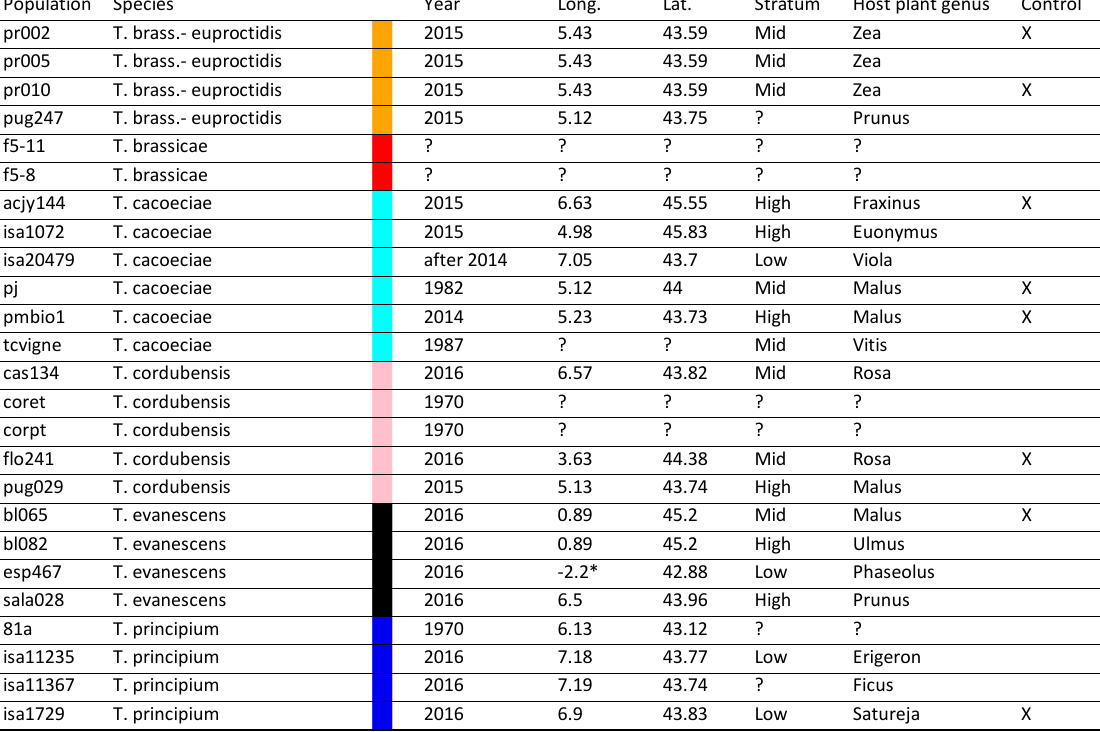
Table 1. List of the 25 populations studied. For each population, species status, year and location of sampling are provided when available. Stratum refers to the height class at which the sampling was realized, and host plant genus refers to the host plant on which the sentinel eggs were attached. Control indicates whether a control treatment was performed for this population (see